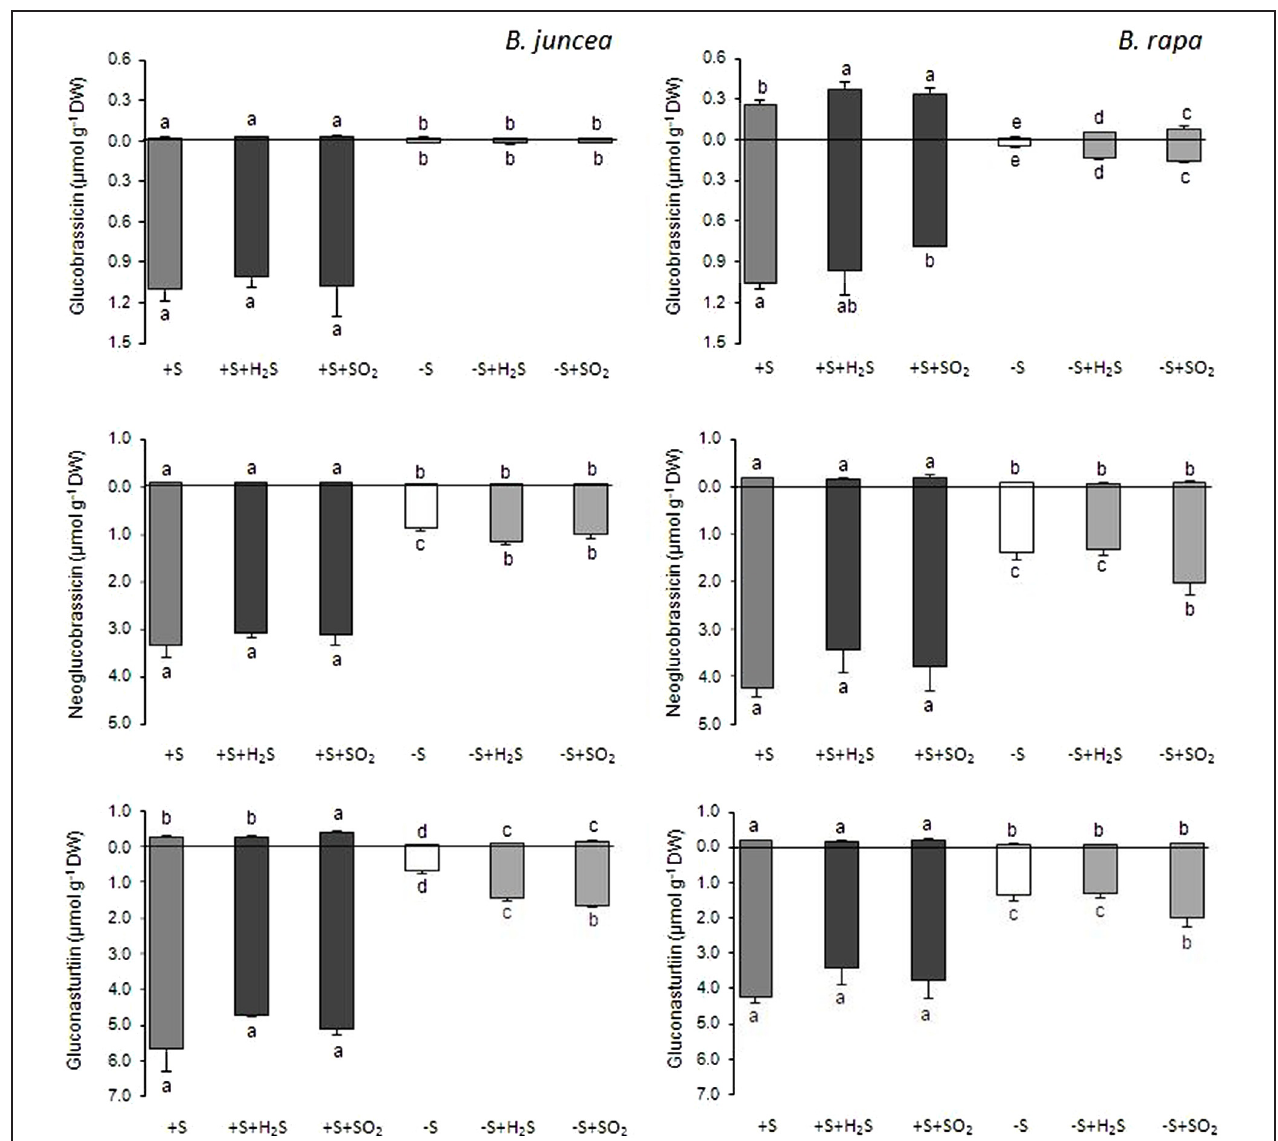
FIGURE 4 | Impact of H 2 S and SO 2 and sulfate deprivation on the content of the indolic and aromatic glucosinolates in shoots (above x axis) and roots (below x axis) of B. juncea and B. rapa . For experimental details, see legends of Figure 1 ; for details on their nomenclature see Table 1 . Data on glucosinolate content ( μ mol g − 1 DW) represent the mean of three measurements with nine plants in each ( ± SD). Different letters indicate significant differences between treatments (P < 0.01, Student’s t